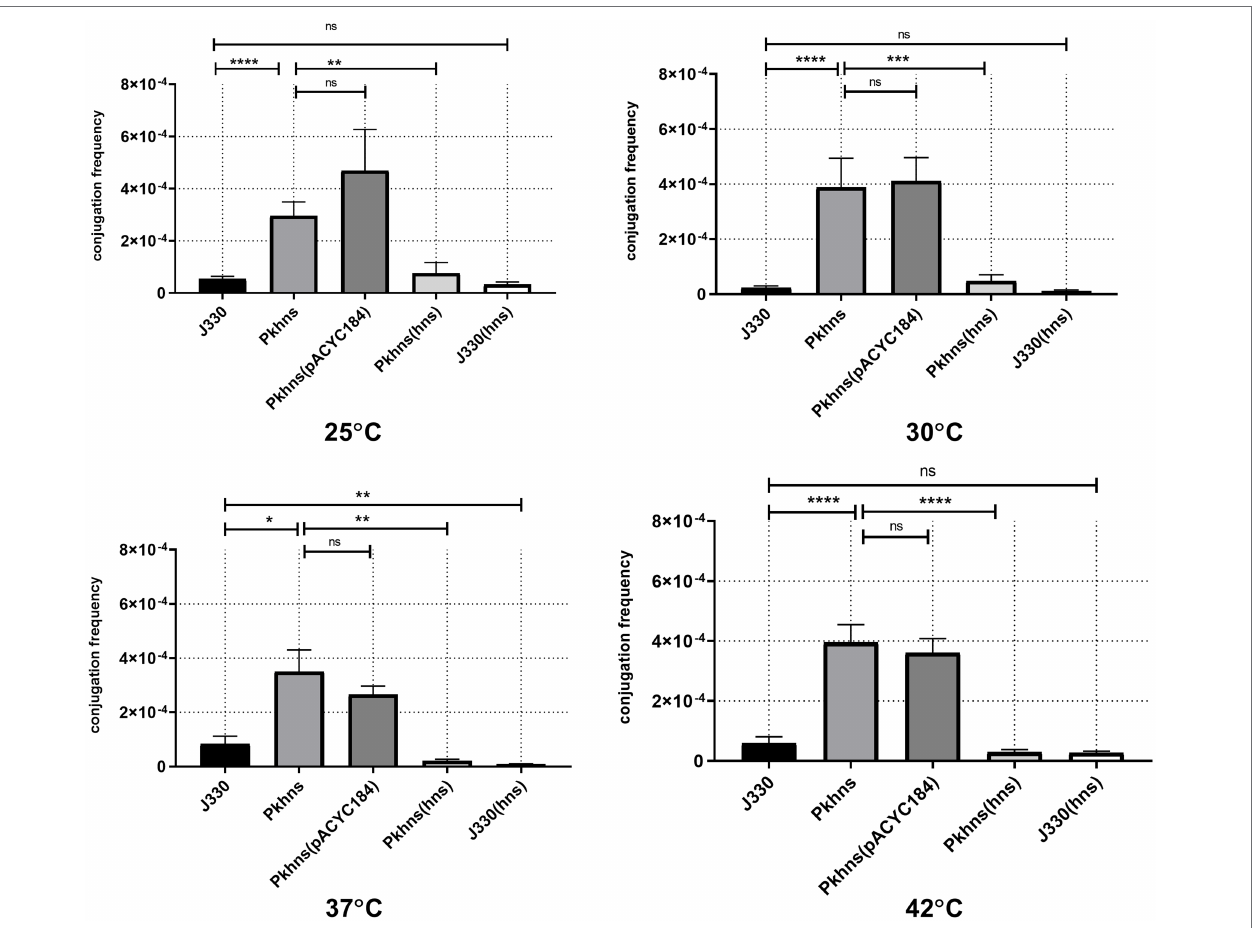
FIGURE 3 | Plasmid-encoded H-NS-like protein represses plasmid transfer at different temperatures. Conjugation frequency at various temperature was evaluated for J330, Pkhns( phns -null strains), corresponding phns complementary strains Pkhns(hns), J330(hns), and corresponding blank-vector complementary strains J330(pACYC184), Pkhns(pACYC184). Variances between different temperature groups were shown with *( p < 0.05), **( p < 0.01), and ***( p < 0.001), ****( p <